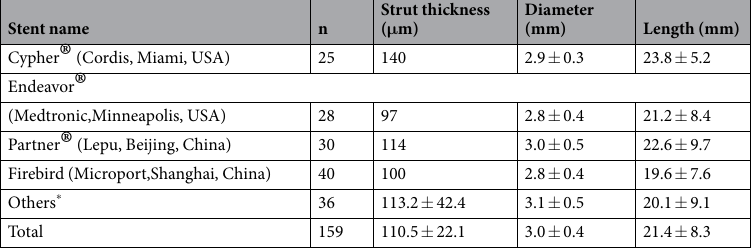
Table 3. Detailed information for included stents. * Taxus ® (Boston Scientific, Natick, USA) n = 6, Excel ® (JW Medical System, Shandong, China) n = 7, Lepu BMS ® (Lepu) n = 9, Driver ® (Medtronic) n = 2, Penta ®